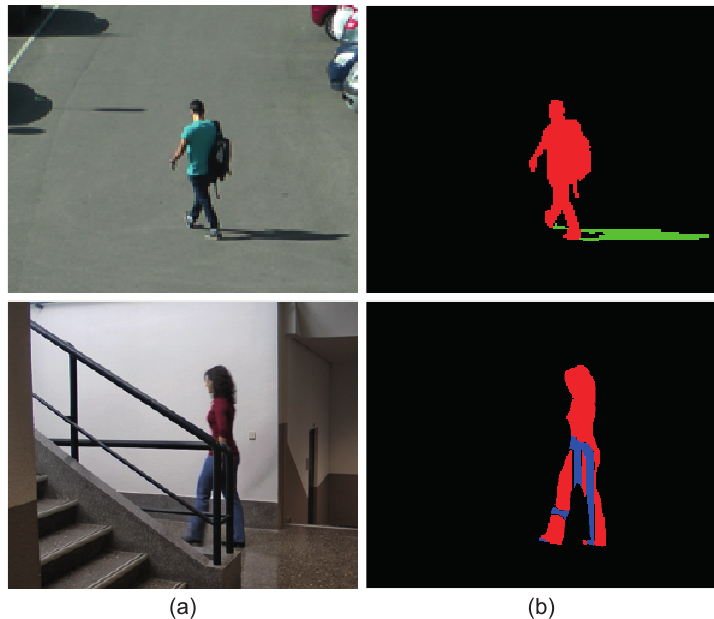
Figure 2. ( a ) Two original images; ( b ) masks of layers. Color notation: visible moving objects (VMO) (red), shadows from moving objects (SMO) (green) and occluded moving objects (OMO)